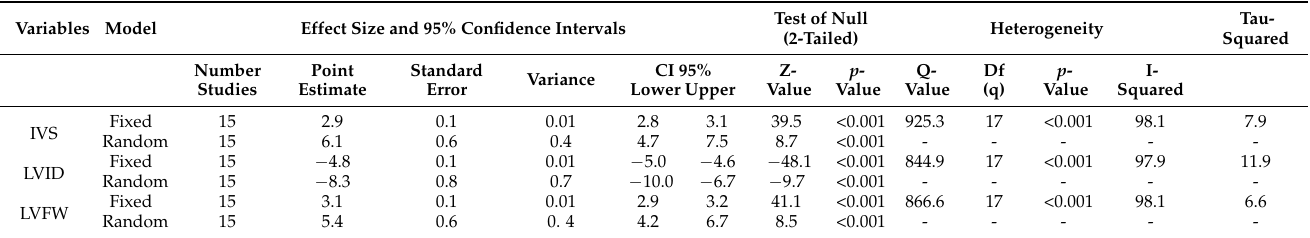
Table 2. Final meta-analysis model for reference values of echocardiographic measurements in Thoroughbred and Standardbred